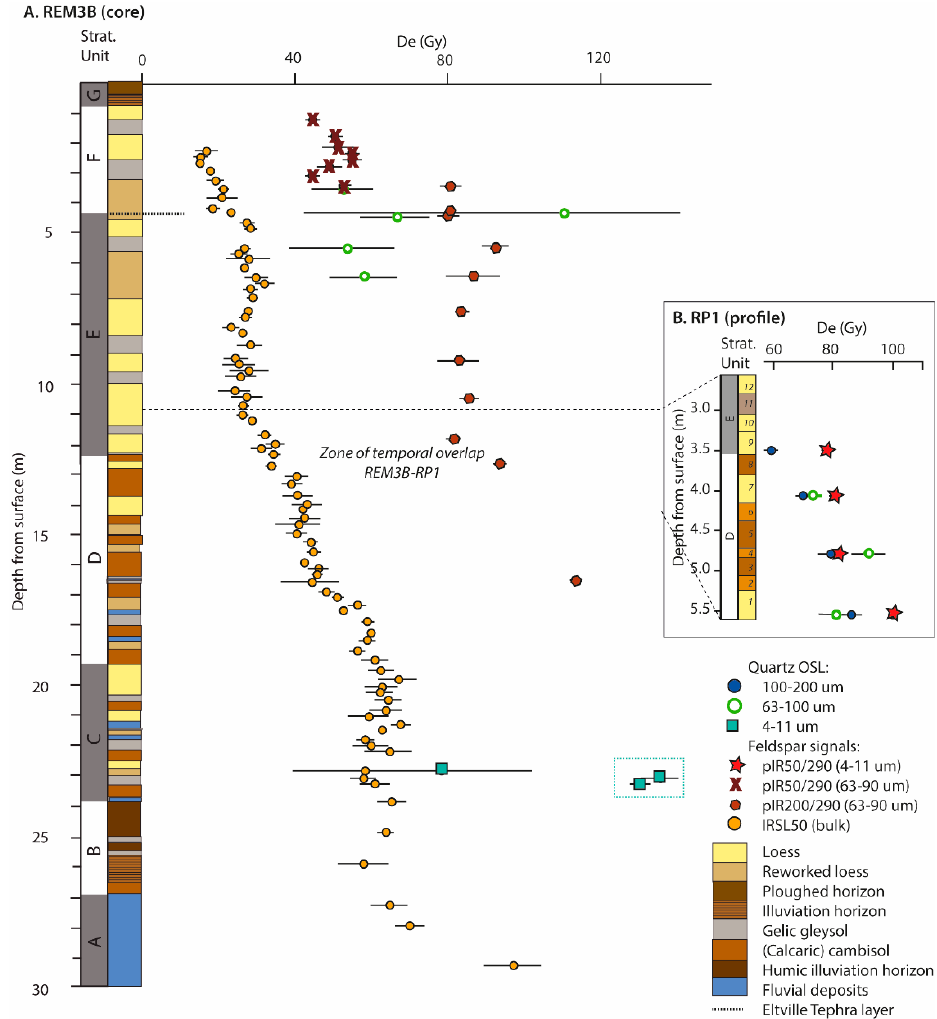
Figure 2. Plots illustrating sample equivalent dose (1 σ error) with depth. ( A ) Equivalent dose vs. depth for the REM3B core, as measured on bulk samples (IR 50 signal; orange), fine-grained (4–11 µm) and very fine sand-sized (63–100 µm) K-feldspar and quartz aliquots. The stratigraphy and stratigraphic units of the REM3 core as defined in [53] are shown for reference. Samples from the fluvial sediments at the base of the core are shown for completeness. ( B ) Equivalent dose vs. depth for the profile RP1 [53] based on 63–100 µm and 100–200 µm quartz and 4–11 µm polymineral measurements. The stratigraphy of the profile is also shown. The zone of temporal overlap between the REM3B core and RP1 profile, using the correlations published in [53], is constrained by dashed lines.